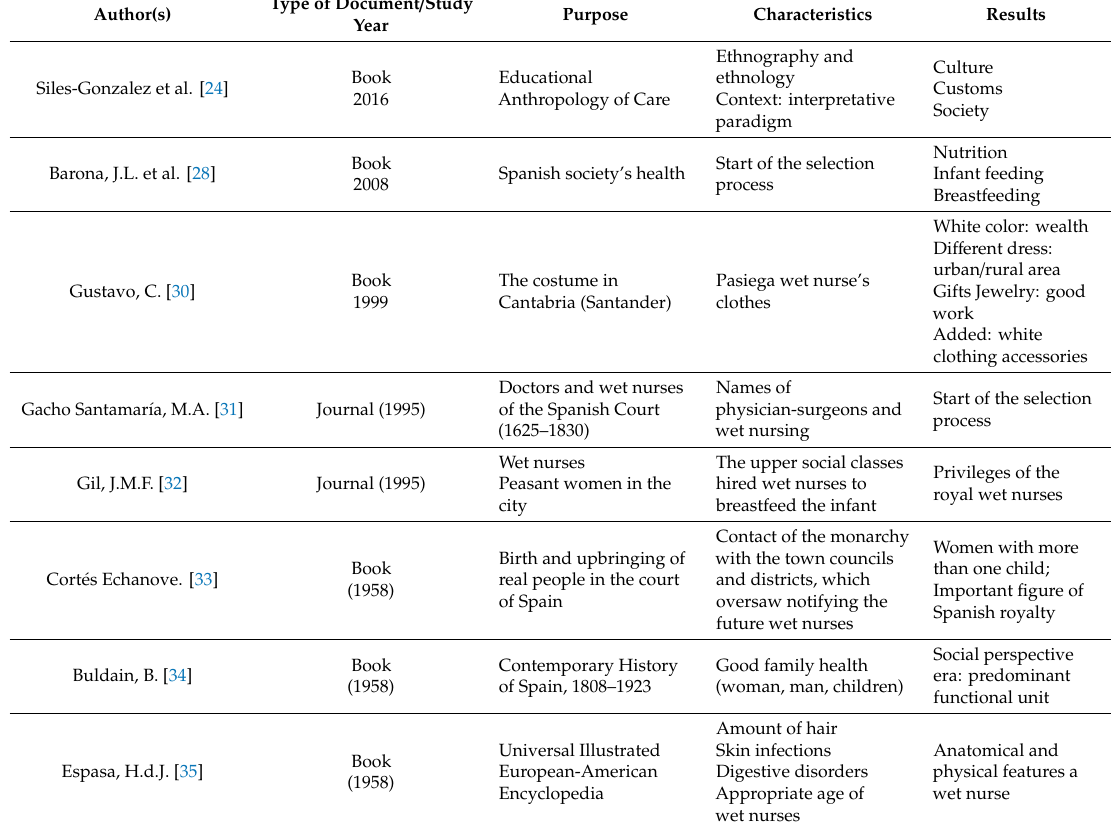
Table 3. Documentation encompassed within the socio-health reality in Spain in relation to the mother of the